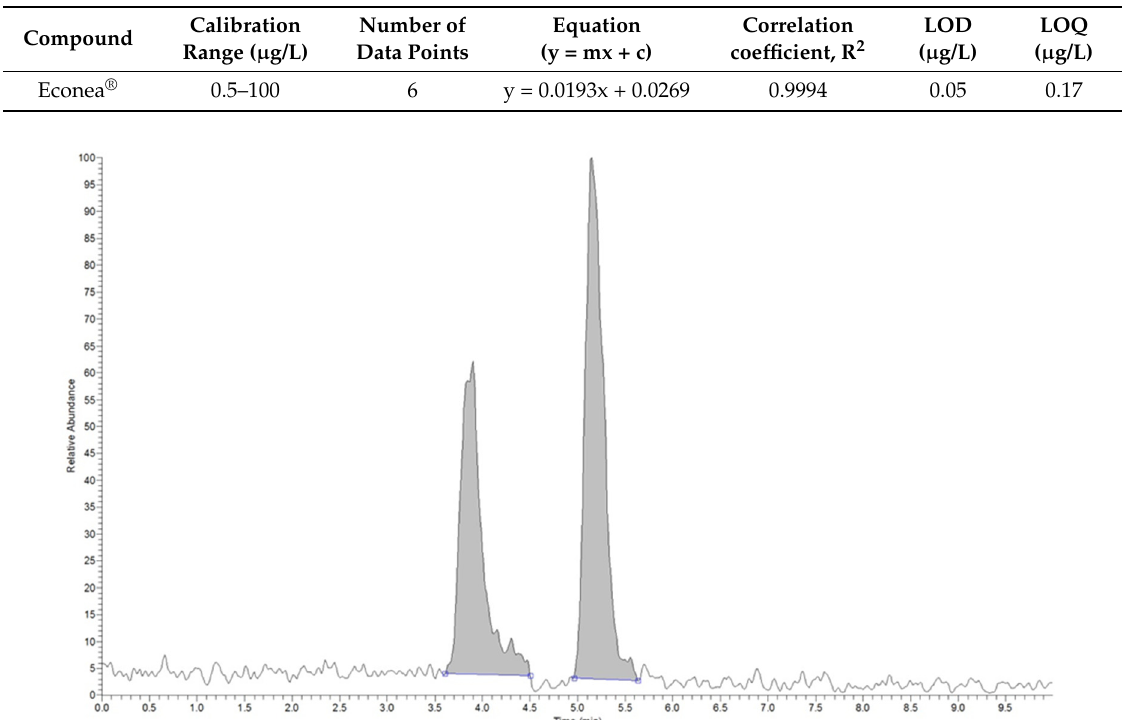
Table 2. Analytical data for the determination of Econea ® .